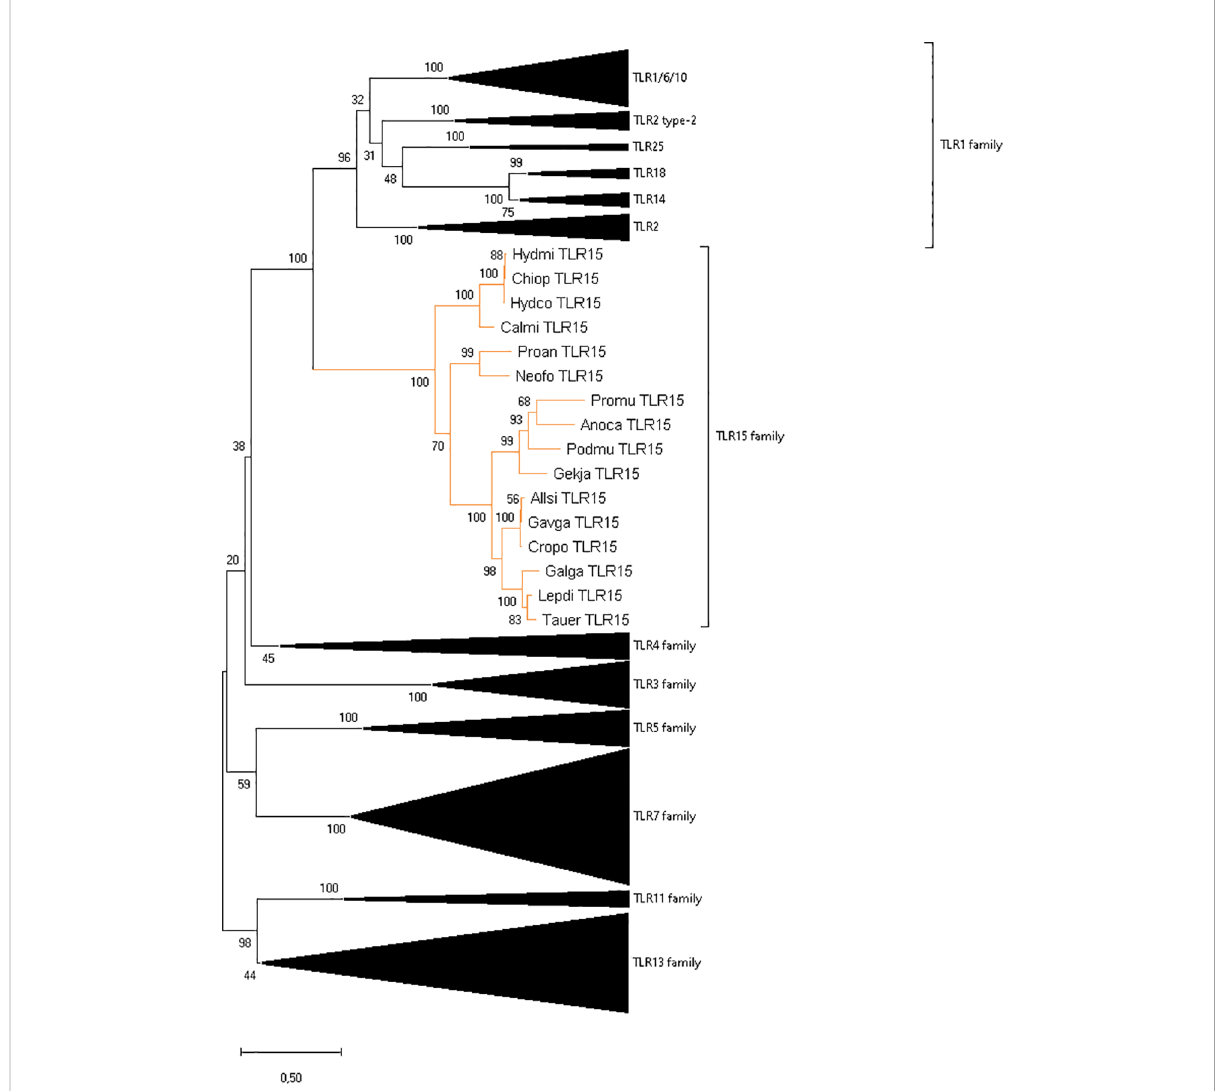
FIGURE 2 Reconstruction of the phylogeny of vertebrate TLR genes showing the division into eight families. The ML tree was built using 259 full length sequences representative of different vertebrate groups, the JTT+G+I amino acid substitution model, and mid-point rooting. The species abbreviations are the same as in Supplementary Figure